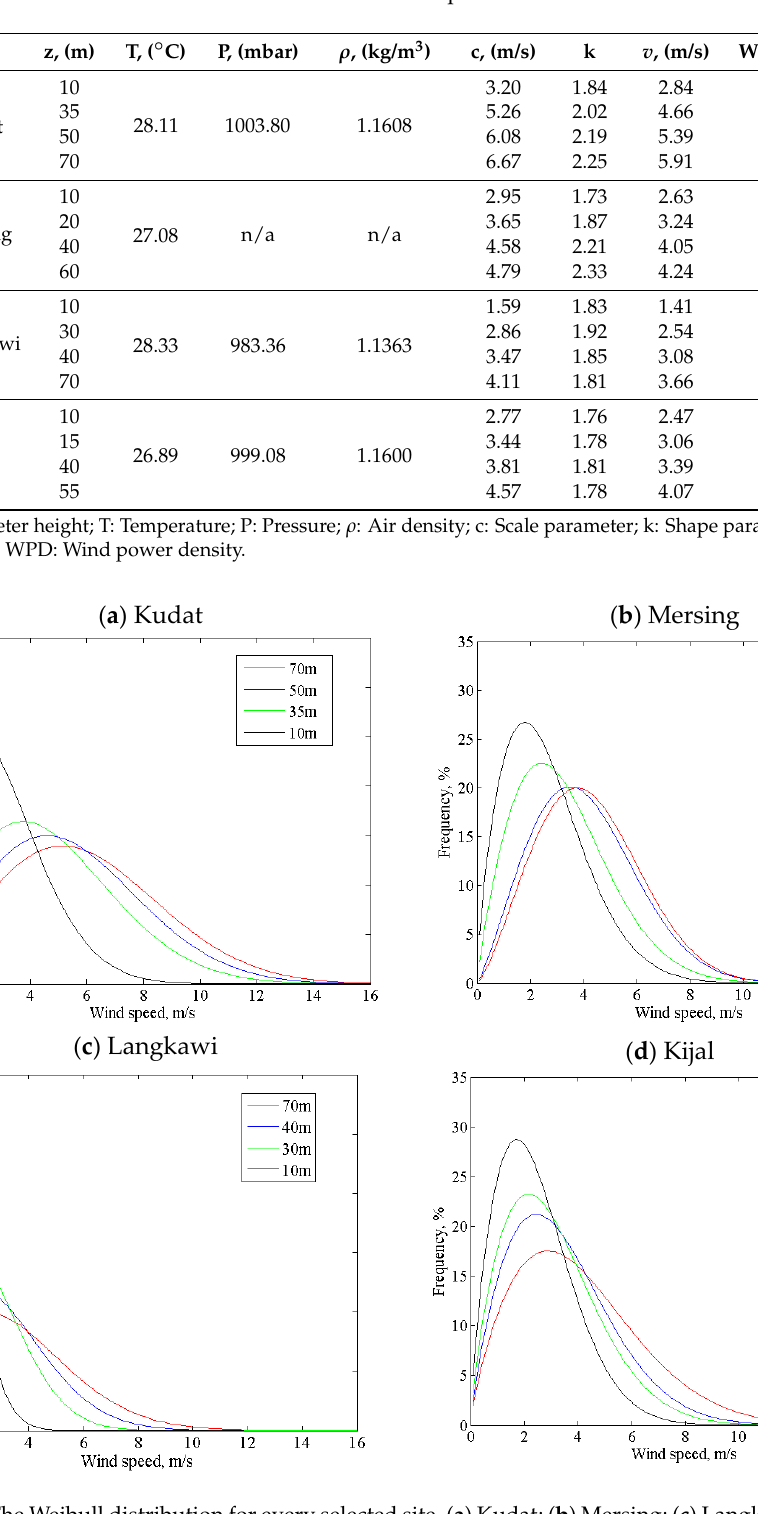
Figure 3. The Weibull distribution for every selected site, ( a ) Kudat; ( b ) Mersing; ( c ) Langkawi; ( d ) Kijal.